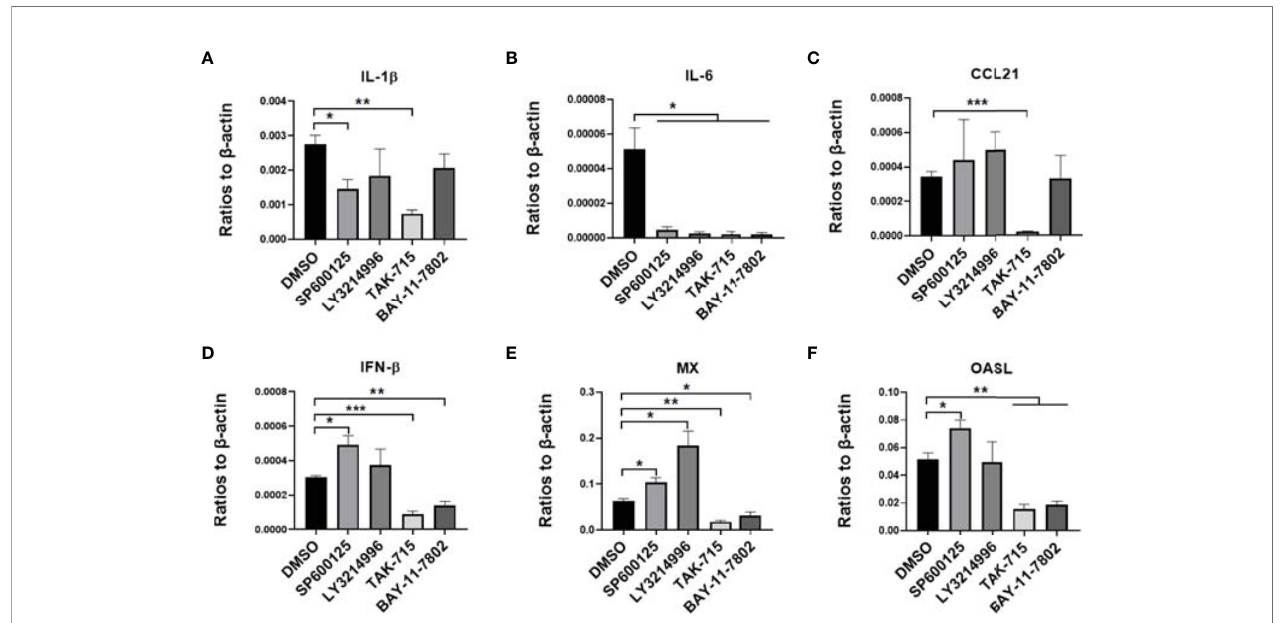
FIGURE 6 | IFN, ISGs, and cytokines were regulated by in fl ammatory signaling in duck MM cells infected with the CHa strain. MM were pretreated with SP600125 (JNK inhibitor), LY3214996 (ERK inhibitor), TAK-715 (p38 inhibitor) and BAY-117082 (NF-kB inhibitor) for 1 h at 10, 5, 5 and 5 M respectively, DMSO as control, then the cells were infected with CHa strain at 5 MOI for 1 h, then the same concentration of inhibitor was added. The expression level of IL-1 b (A) , IL-6 (B) , CCL21 (C) , IFN- b (D) , MX (E) , and OASL (F) were tested using RT-qPCR 24 h post-treatment. The relative expression was presented as ratios to b -actin compared to mock treatment. “ * ” was considered signi fi cant difference ( p < 0.05); “ ** ” was considered highly signi fi cant difference ( p < 0.01); “ *** ” was considered highly signi fi cant difference ( p <